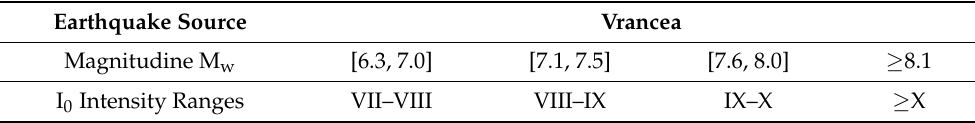
Table 6. Potential ranges for parametric triggers. Earthquake Source